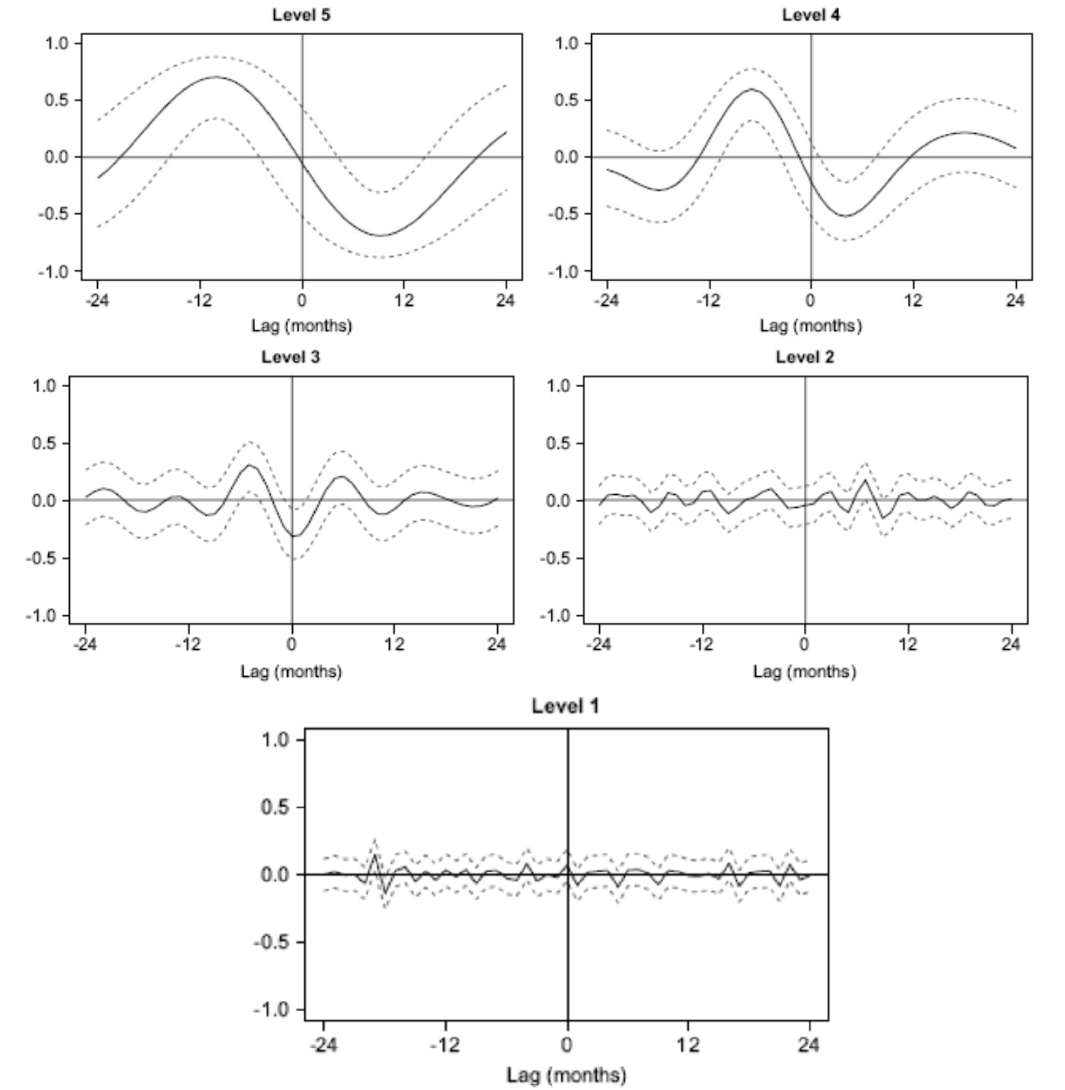
Fig. 5. Wavelet cross-correlations between BSE and NSE